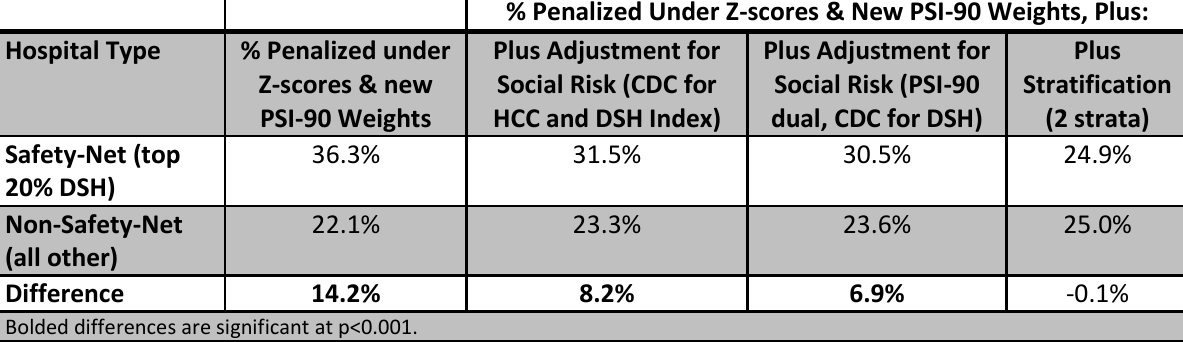
Table 6.25: Percent Penalized under Winsorized Z-scores and Harms-Based Weights plus Adjustment or